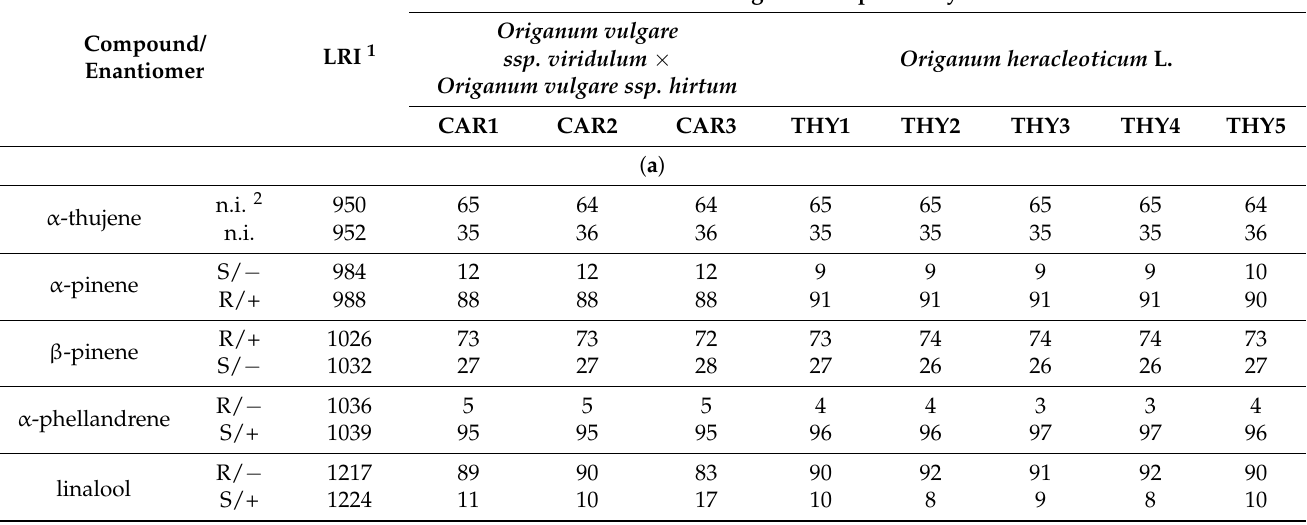
Table 2. ( a ) Enantiomeric distributions (%) of chiral compounds determined after isolation by HS- SPME from oregano dried leaves and flowers of the hybrid Origanum vulgare ssp. viridulum × Origanum vulgare ssp. hirtum (CAR1, CAR2, CAR3) and of the subspecies Origanum heracleoticum L. (THY1, THY2, THY3, THY4, THY5). ( b ) Enantiomeric distributions (%) of chiral compounds deter- mined from EOs of the hybrid Origanum vulgare ssp. viridulum × Origanum vulgare ssp. hirtum (CAR1, CAR2, CAR3) and the subspecies Origanum heracleoticum L. (THY1, THY2, THY3, THY4, THY5).